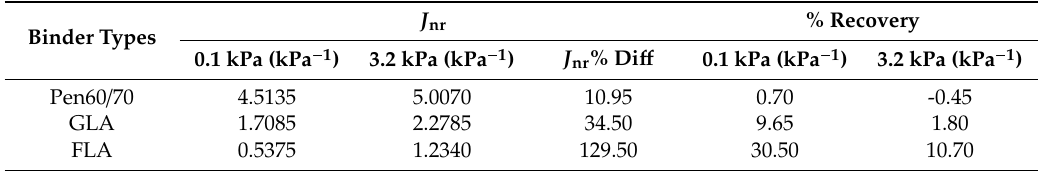
Table 3. Multiple stress creep recovery (MSCR) test results.